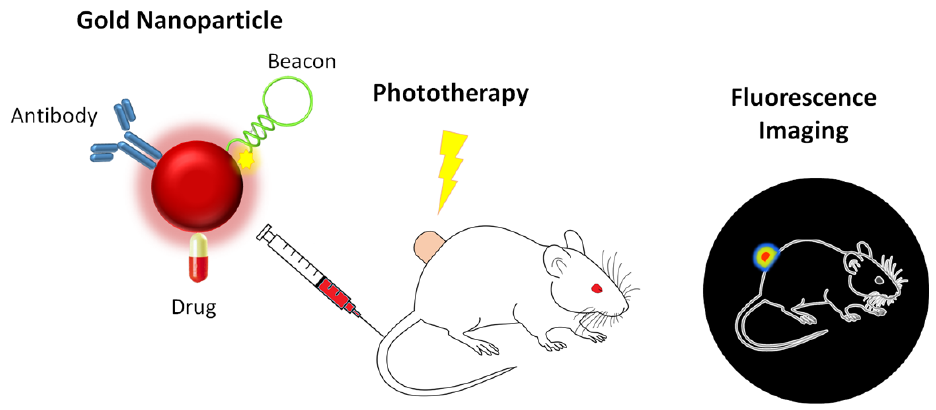
Figure 2. Schematics of a multifunctional approach, coupling targeting, chemotherapy, gene therapy, phototherapy and diagnostics by fluorescent